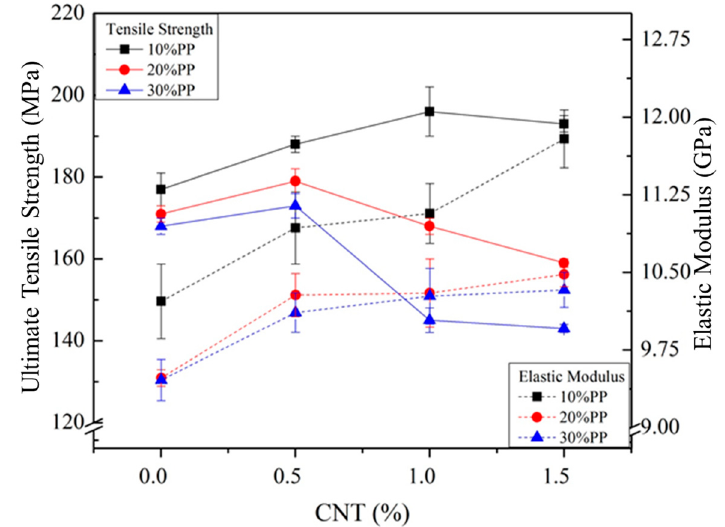
Figure 2. Tensile strength and elastic modulus results of CF- and CNT-reinforced PA6/PP composites with different PP and CNT compositions.